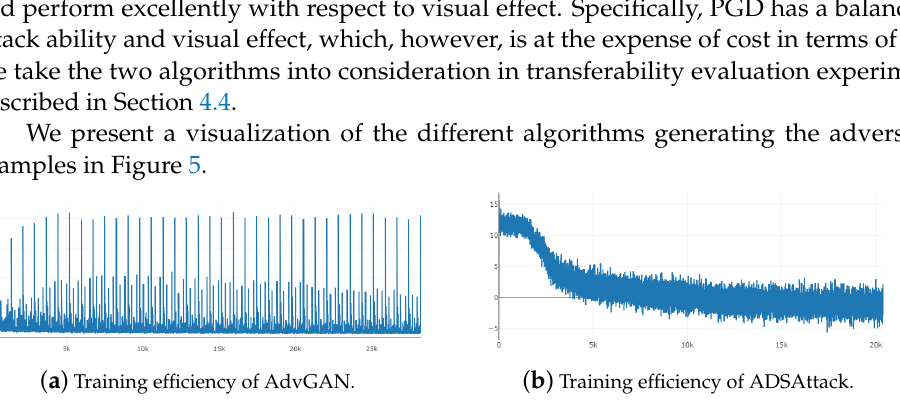
Figure 5. Training efficiency, illustrated by convergence curves of the loss during training procedure of generative networks, of AdvGAN and